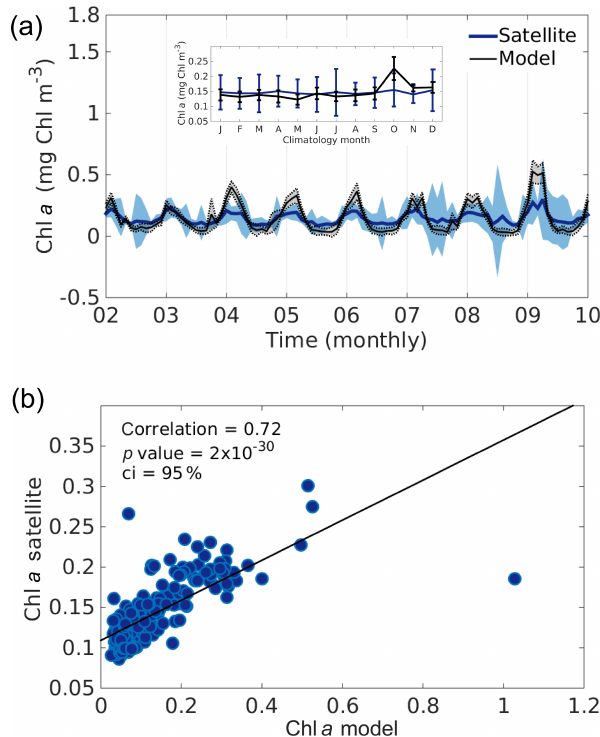
Figure A5. (a) Temporal series of surface chlorophyll in milligrams of chlorophyll per cubic metre from the satellite and model for the whole deep GoM. Standard deviations from the spatial averages are shown in shaded blue areas for the satellite and dashed black lines for the model. The monthly climatology of the temporal series is shown in the upper part of the figure, where vertical bars indicate standard deviation from the temporal mean. In (b) are represented the correlation coefficients of both monthly temporal series and their respective linear fit as black lines. The slope of the linear fit is